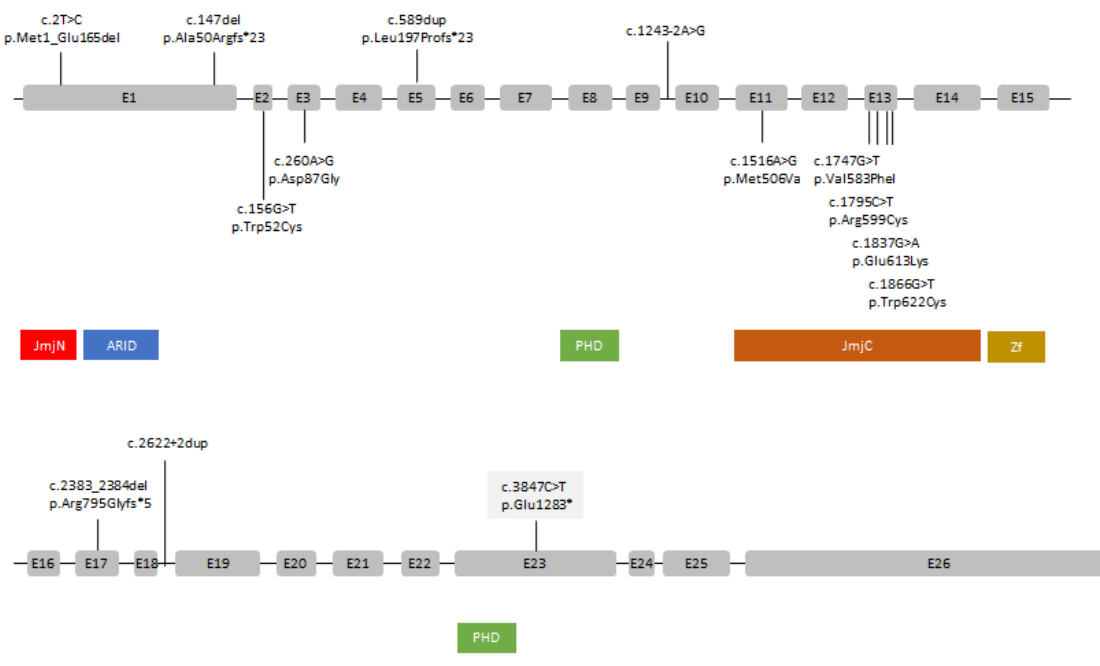
Figure 3. Schematic structure of the KDM5C gene and its known pathogenic variants. Exons are in scale; introns are not in scale. Exons belonging to isoform NM_004187.5 are shown by grey rectangles. The mutation found in the present patient is shown with a grey background. Truncating (i.e., nonsense and frameshift) and splicing variants are shown at the top, while non-synonymous and in-frame alterations are shown at the bottom. E: exon. Proteins’ functional domains are shown as colored rectangles under the gene scheme and include ARID: helix–turn–helix motif-based DNA-binding domain; JmjC: catalyzes demethylation of H3K4me3 to H3K4me1 JmjN: interacts with JmjC PHD: histone-methyl-lysine binding